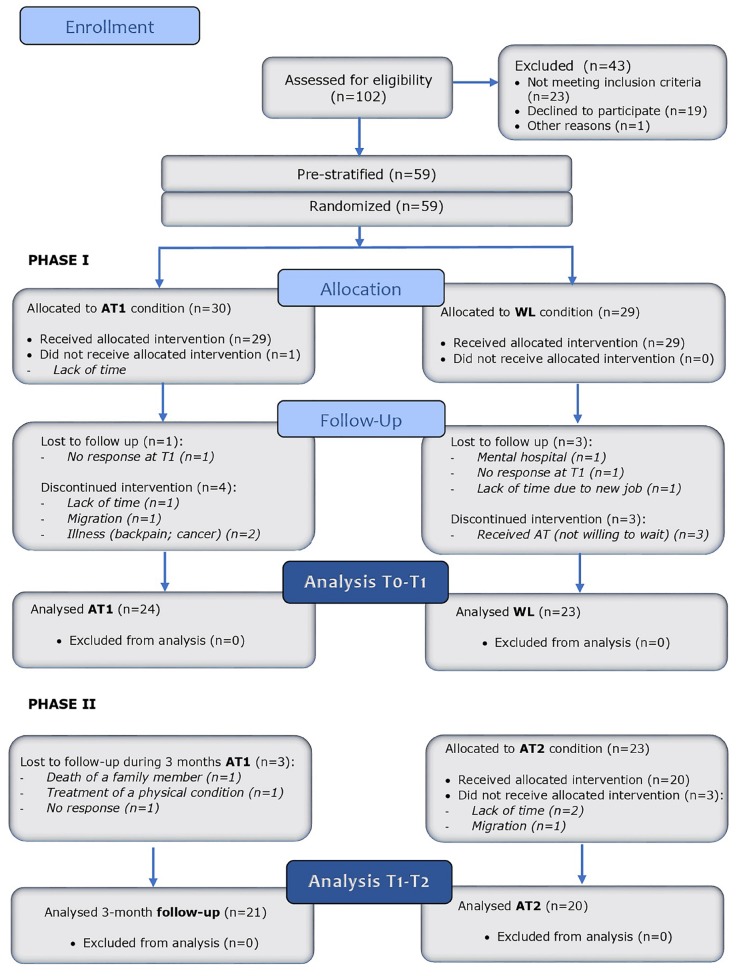
Study flow diagram.